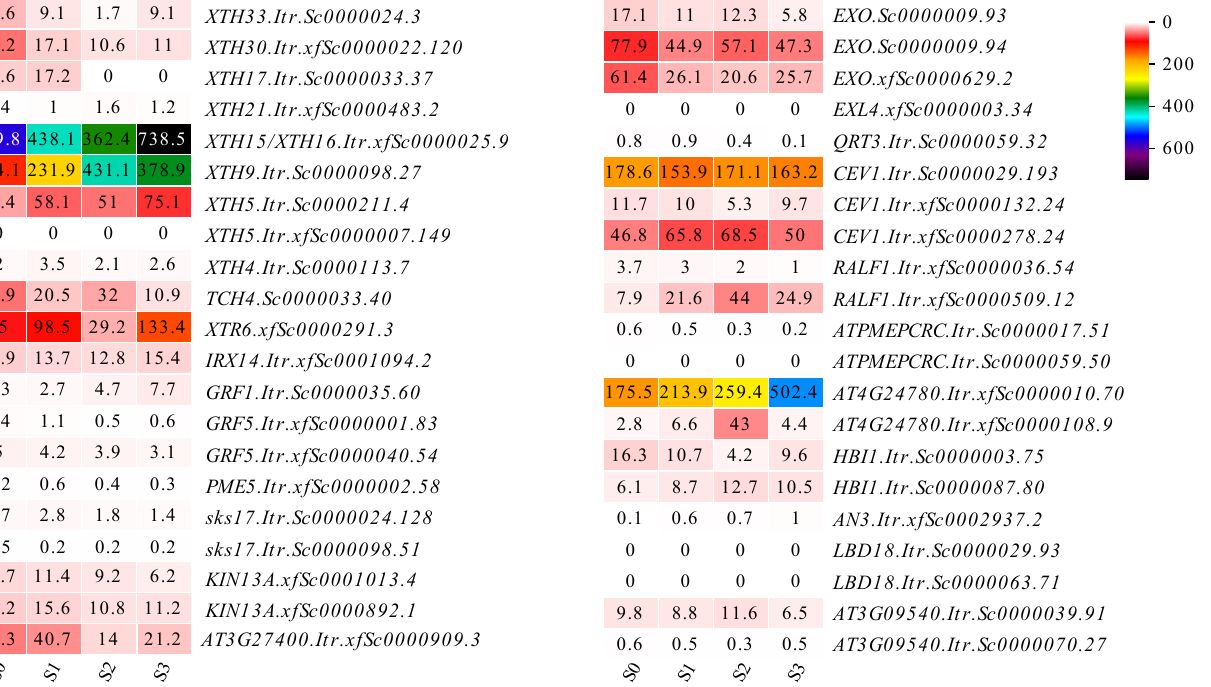
Figure 8. Gene expression of development related proteins that interacted with expansins in Y22 SR development. The gene ID of I. trifida (Y22) added later at protein gene name was the protein gene name of I. trifida (Y22).